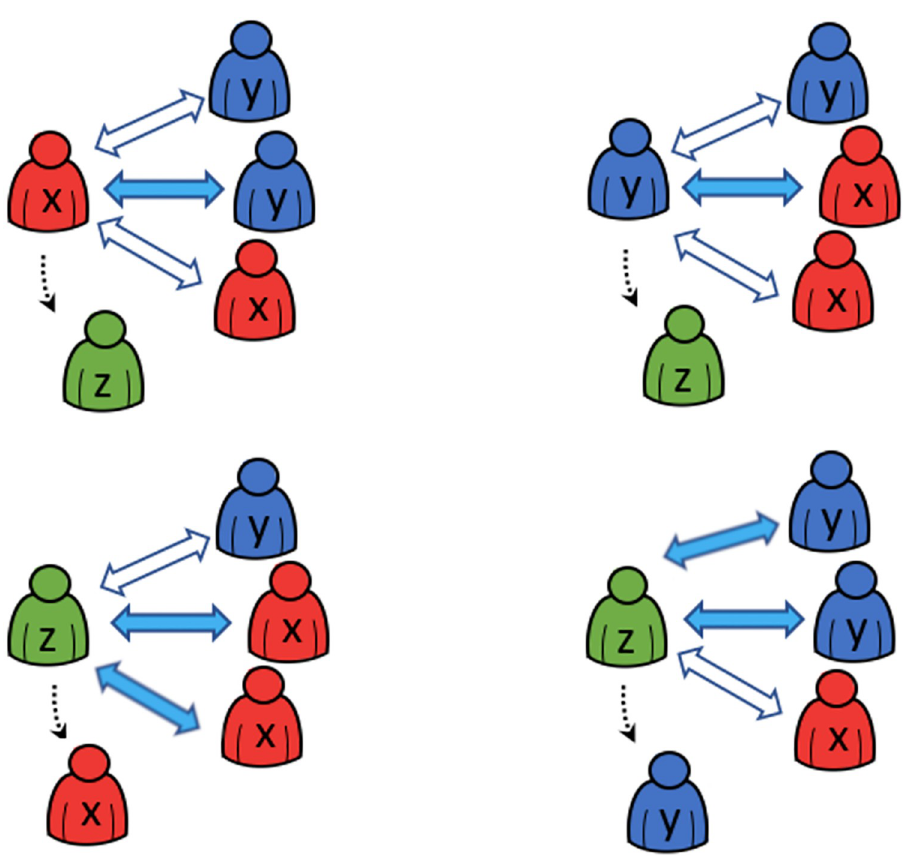
Fig 2. A generic quantised consensus process. Individual X meets m Individuals Y and mutates into Individual Z with probability P XZ = p 1 (top-left); Individual Y meets m Individuals X and mutates into Individual Z with probability P YZ = p 2 (top-right); Individual Z meets d Individuals X and mutates into Individual X with probability P ZX = p 3 (bottom-left); Individual Z meets d Individuals Y and mutates into Individual Y with probability P ZY = p 4 (bottom-